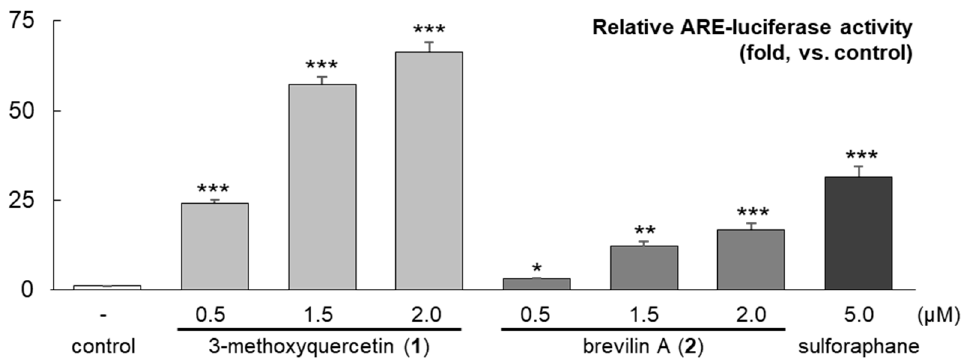
Figure 4. Relative ARE-luciferase activities of the purified compound. The ARE induction activities of compounds 1 and 2 were evaluated in ARE-HepG2 cells at concentrations of 0.5, 1.5, and 2.0 µ M. Data are presented as the mean ± S.E. ( n = 3). * p < 0.05; ** p < 0.01; *** p < 0.005 (compared with the vehicle-treated control).